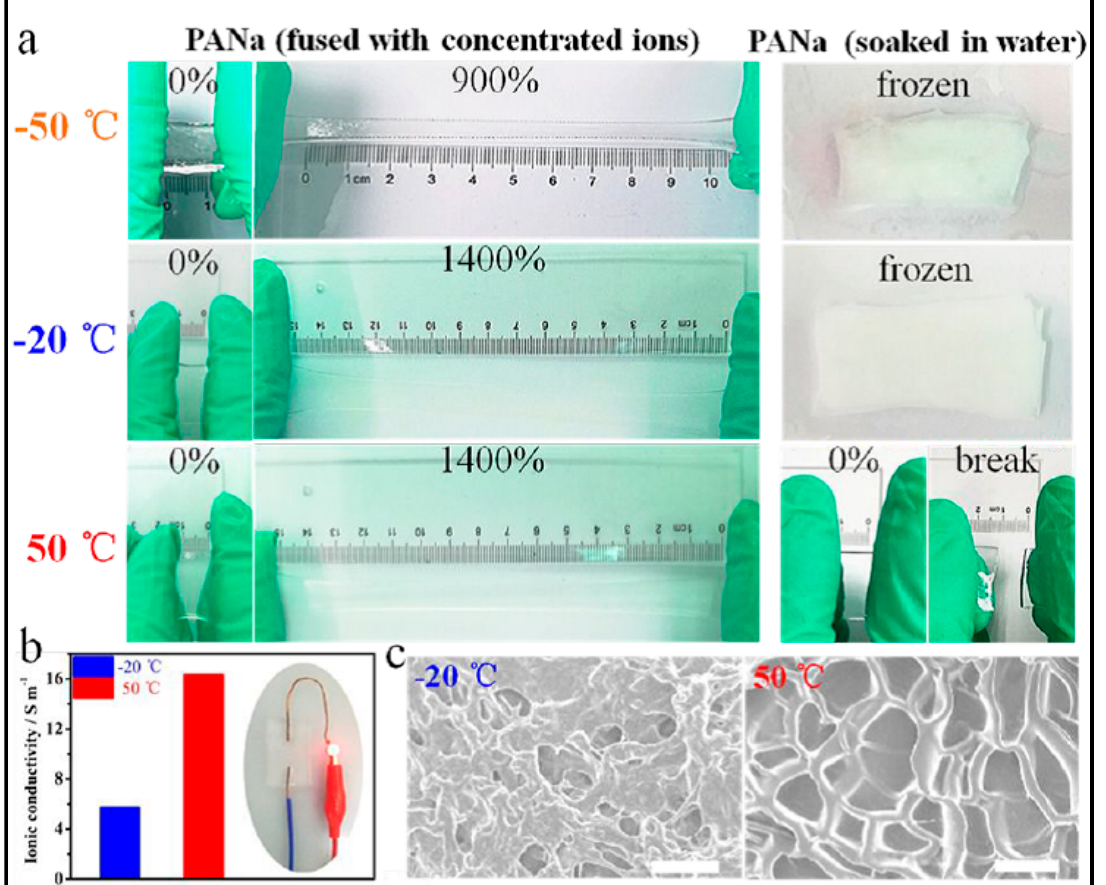
Figure 15. Physicochemical characterization of the electrolyte and the electrode. ( a ) The stretchability of the PANa hydrogel at different temperatures infused with concentrated ions and deionized water, respectively. ( b ) Ionic conductivities of the highly concentrated PANa hydrogel at different temperatures. The inset image shows the PANa hydrogel electrolyte used as an ionic conductor to successfully connect the LED circuit. ( c ) SEM images of the freeze-dried PANa hydrogel at different temperatures ( left : − 20 °C, right : 50 °C). Reproduced with permission from [170]. Copyright 2019 The American Chemical Society.